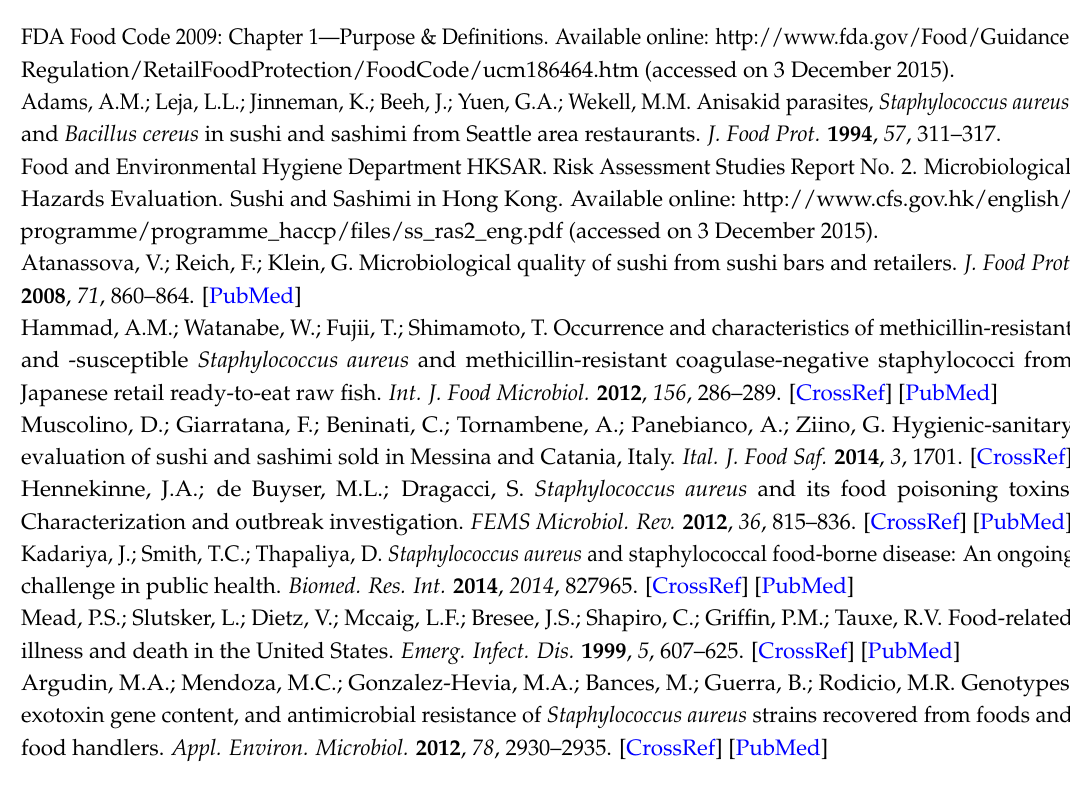
Table S1. Primer nucleotide sequences for DNA amplification and amplified amplicon sizes of 32 virulence genes of Staphylococcus